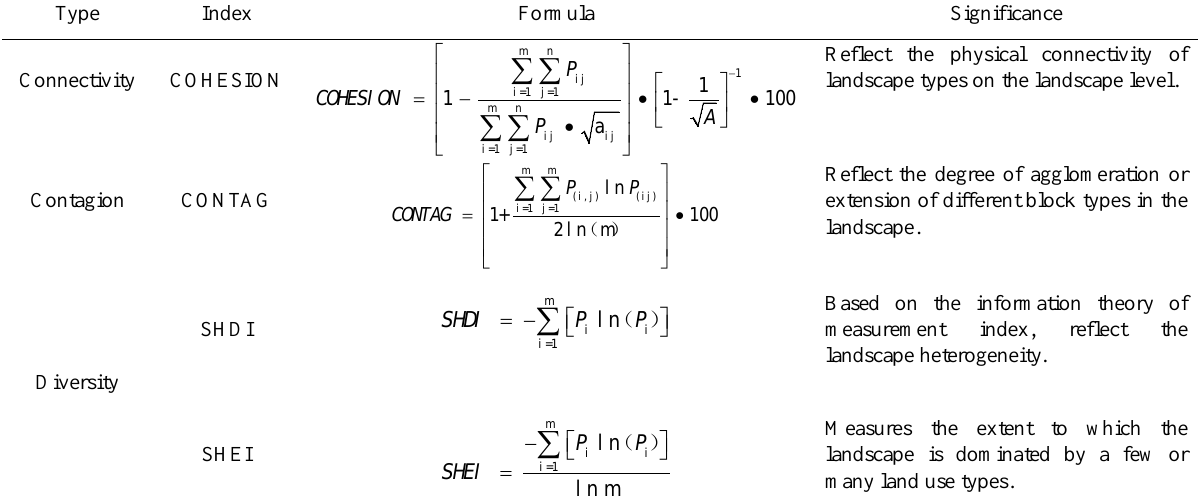
Table 1. Description of landscape